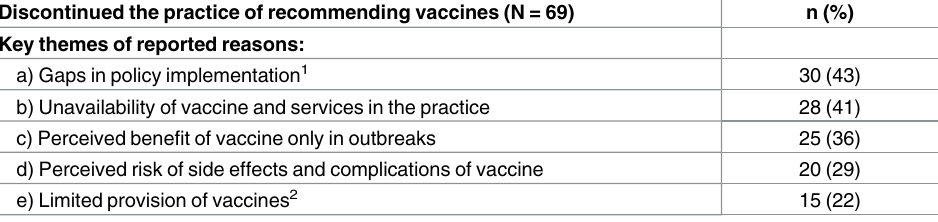
Table 6. Open-ended responses of Thai physician to perceived barriersof influenza vaccination of pregnant